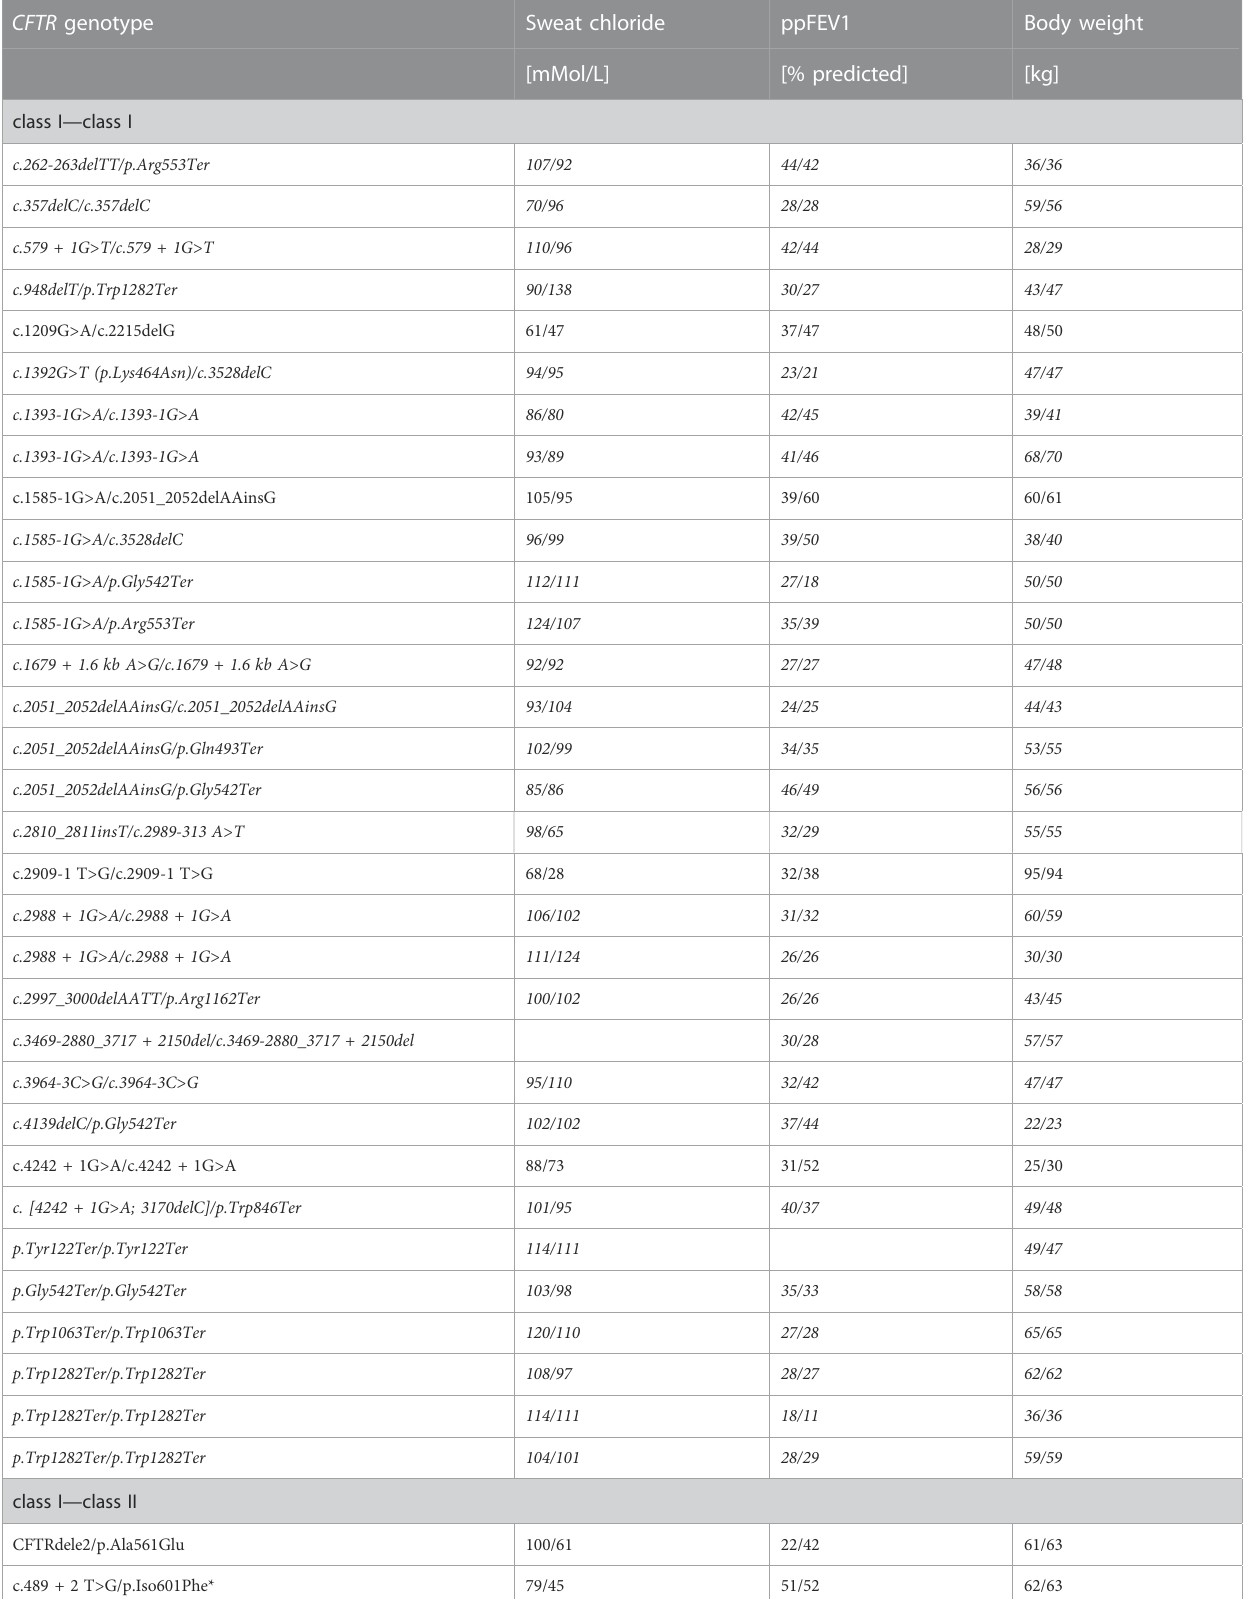
TABLE 3 Rare non-p.Phe508del CFTR genotypes assessed for ELX/TEZ/IVA - mediated CFTR modulation by sweat test, spirometry and body weight in pwCF with advanced lung disease (Burgel et al., 2023). Sequence variants are differentiated by CFTR mutation class: class I, minimal function; class II, defective in protein processing and traf fi cking; class III: defective gating; class IV, change of ion channel conductance; class V, reduced amount of wild type